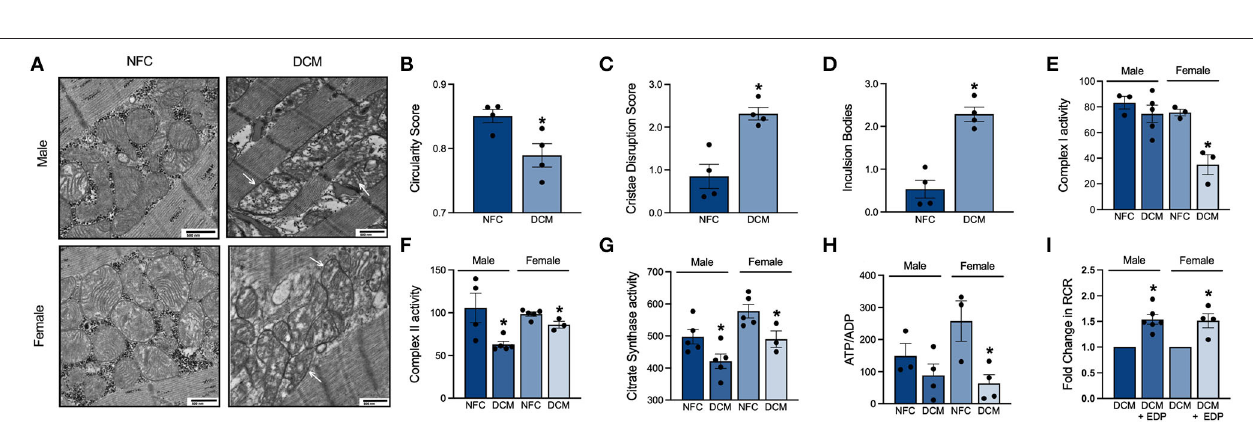
FIGURE 1 | (A) Fold change in mRNA expression of key enzymes in DCM LV tissue vs. NFC based on microarray analysis (NFC n = 8 and DCM n = 8; NC = no change). Western immunoblot quantification and representative blots showing protein expression of (B) , CYP2J2; (C) , CYP2C8; (D) , mEH; (E) , sEH enzymes in microsomal and cytosolic heart tissue fractions. Data are expressed as mean ± SEM and analyzed using one-way ANOVA with Tukey’s multiple comparisons test (each individual patient heart = n , male NFC n = 6, female NFC n = 6, male DCM n = 6, female DCM n = 6, * p < 0.05 vs. NFC). The same loading control image is used for illustrative purposes in (B–D) .